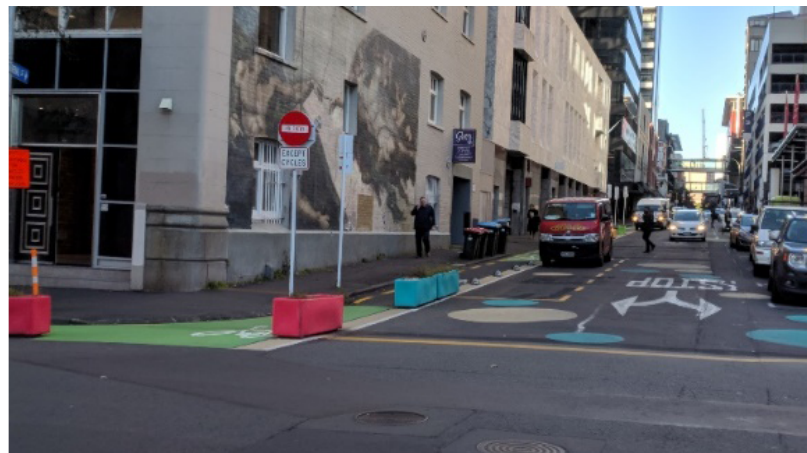
Figure 2. Placekit, is an example of using global solutions for local issues. Only few weeks after installation, the plants dried out, no local community of care existed amongst the businesses and residents living on the street to support the success of the installation and the Council agency didn’t follow through to maintain the planters in support of a care for